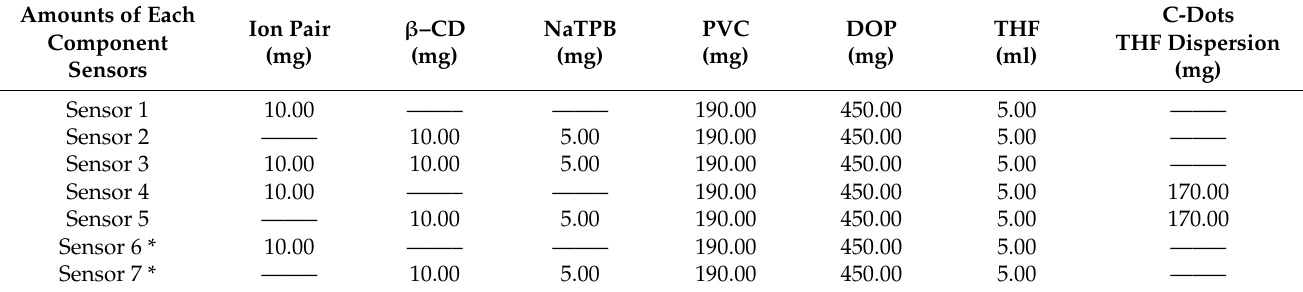
* In case of sensors 6 and 7, carbon quantum dot (CQD) SDS dispersion is part of ink composition.